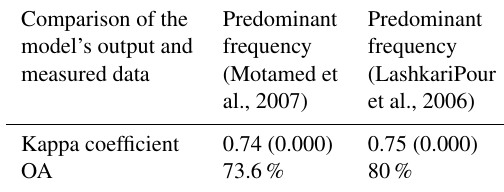
Table 5. Kappa coefficient and